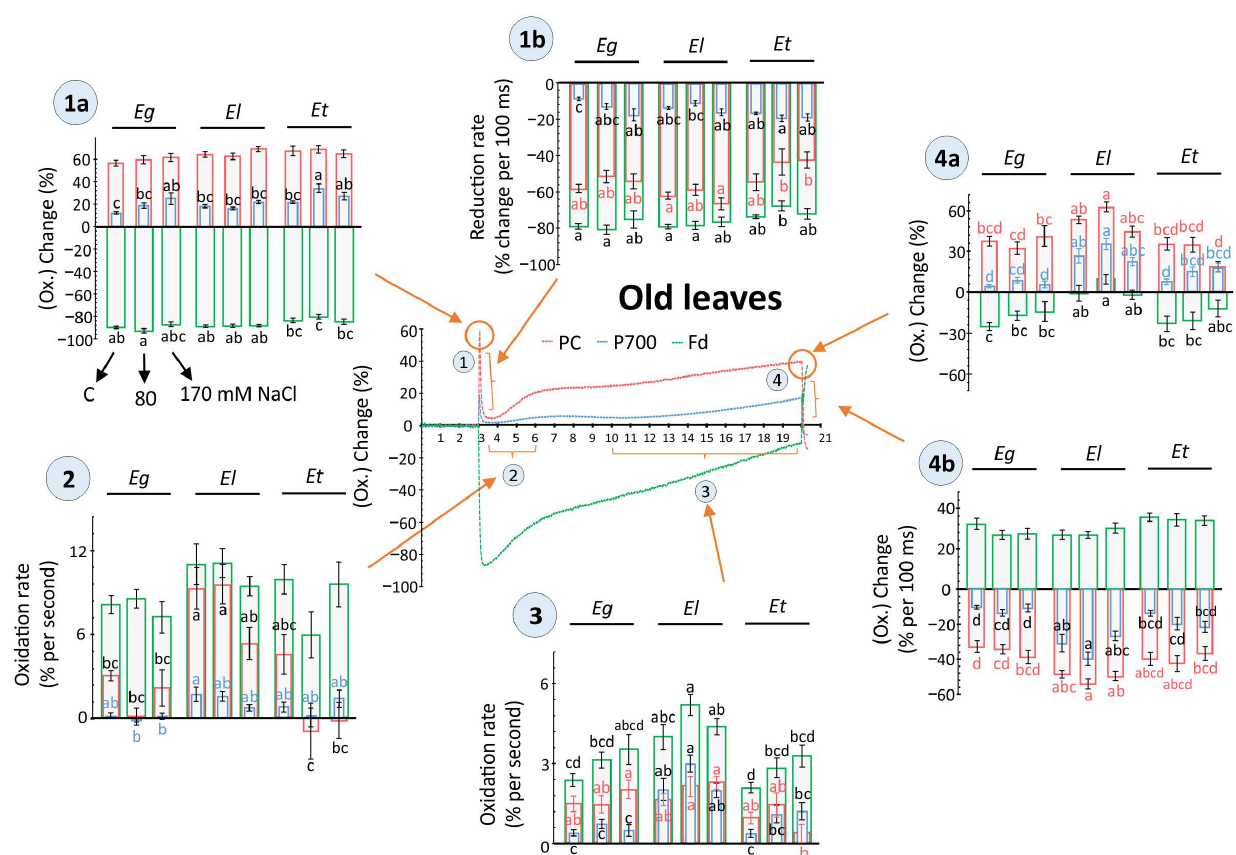
Figure 6. Light-driven redox changes for PC, P700 (PSI) and Fd as recorded in old leaves of Eucalyptus spp under salt stress. Dark-adapted, detached old leaves of 30 d salt treated Eucalyptus spp were exposed to 160 µ mol m − 2 s − 1 for 17 s and redox states of plastocyanins (PC), photosystem I (PSI) and ferredoxin (Fd) were recorded along with chlorophyll a fluorescence (Figure 4) using the DUAL-KLAS-NIR (Walz, Germany). The scatter plot showing representative kinetics of light-driven redox change was divided into four different phases, as indicated i.e., 1(a, b), 2, 3, and 4(a, b), based on light-dependent temporal shifts in the redox state of PC, PSI, and Fd (Phase 1 = Dark to light shift, Phase 2, 3 = dynamics of reoxidation and apparent steady state, Phase 4 = end of light phase and light to dark shift. In phase 1 and 4, ‘a’ = max. value, ‘b’ = rate of redox shift). For individual phases, the redox changes were compared among plant species and different salt treatments and are shown as histograms in form of maximal change or rate of redox transition (means ± SE, n = 9–12, p < 0.05; ANOVA and Tukey’s post-hoc test). The data between 6–10 s were excluded due to observed high